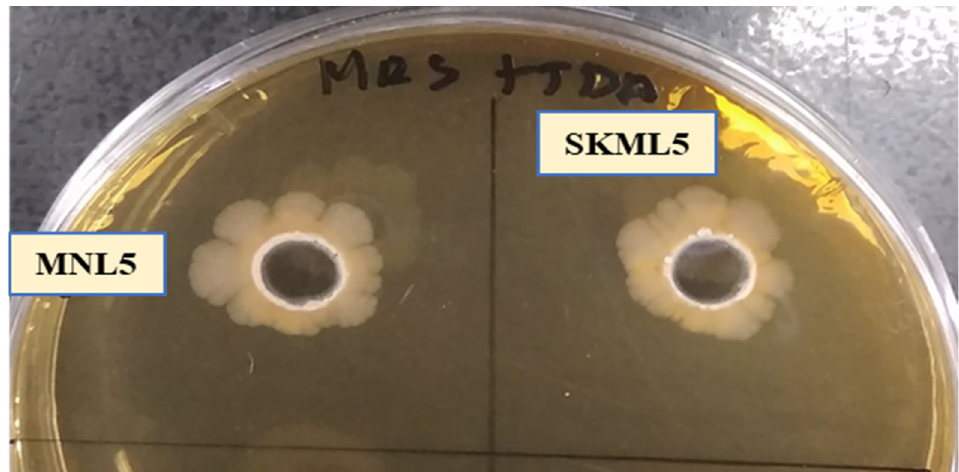
Figure 1. (The BSH activity of LAB isolates grown on bile salt–MRS medium as manifested by the formation of precipitation zone around the colony.